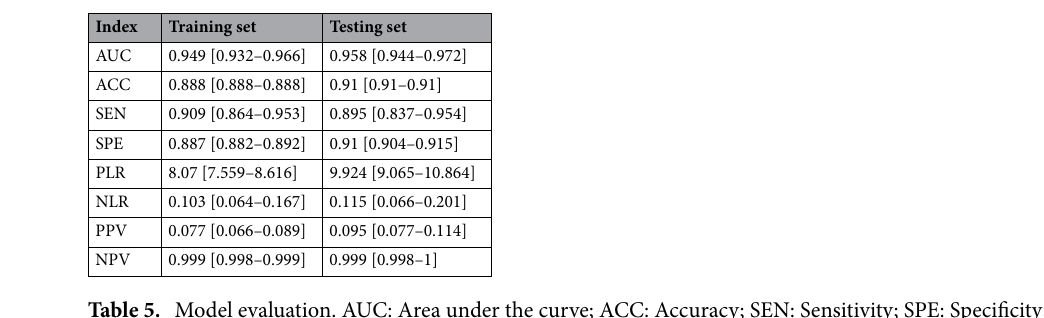
Table 5. Model evaluation. AUC: Area under the curve; ACC: Accuracy; SEN: Sensitivity; SPE: Specificity; PLR: Positive likelihood ratio; NLR: Negative likelihood ratio; PPV: Positive predictive value; NPV: Negative predictive